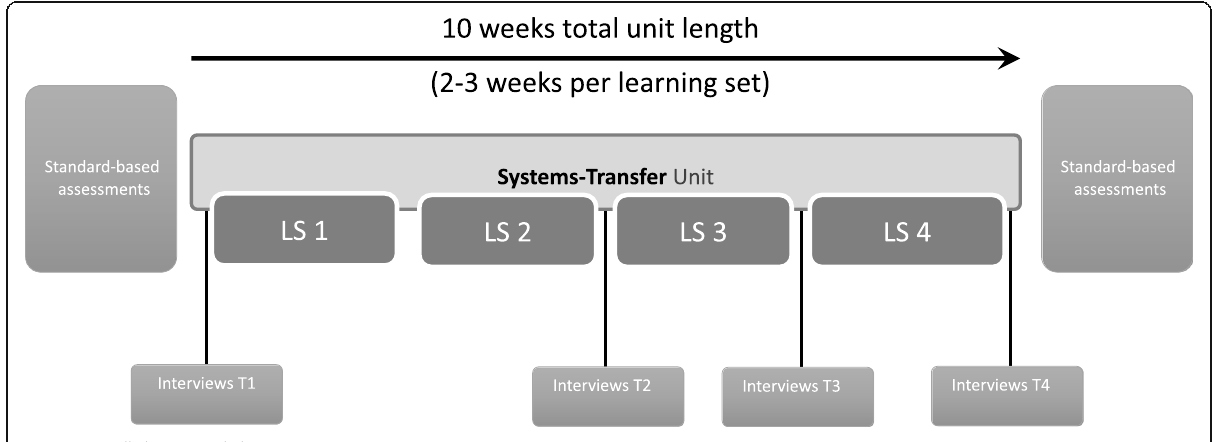
Fig. 1 Overall design and data sources. LS = Lesson set